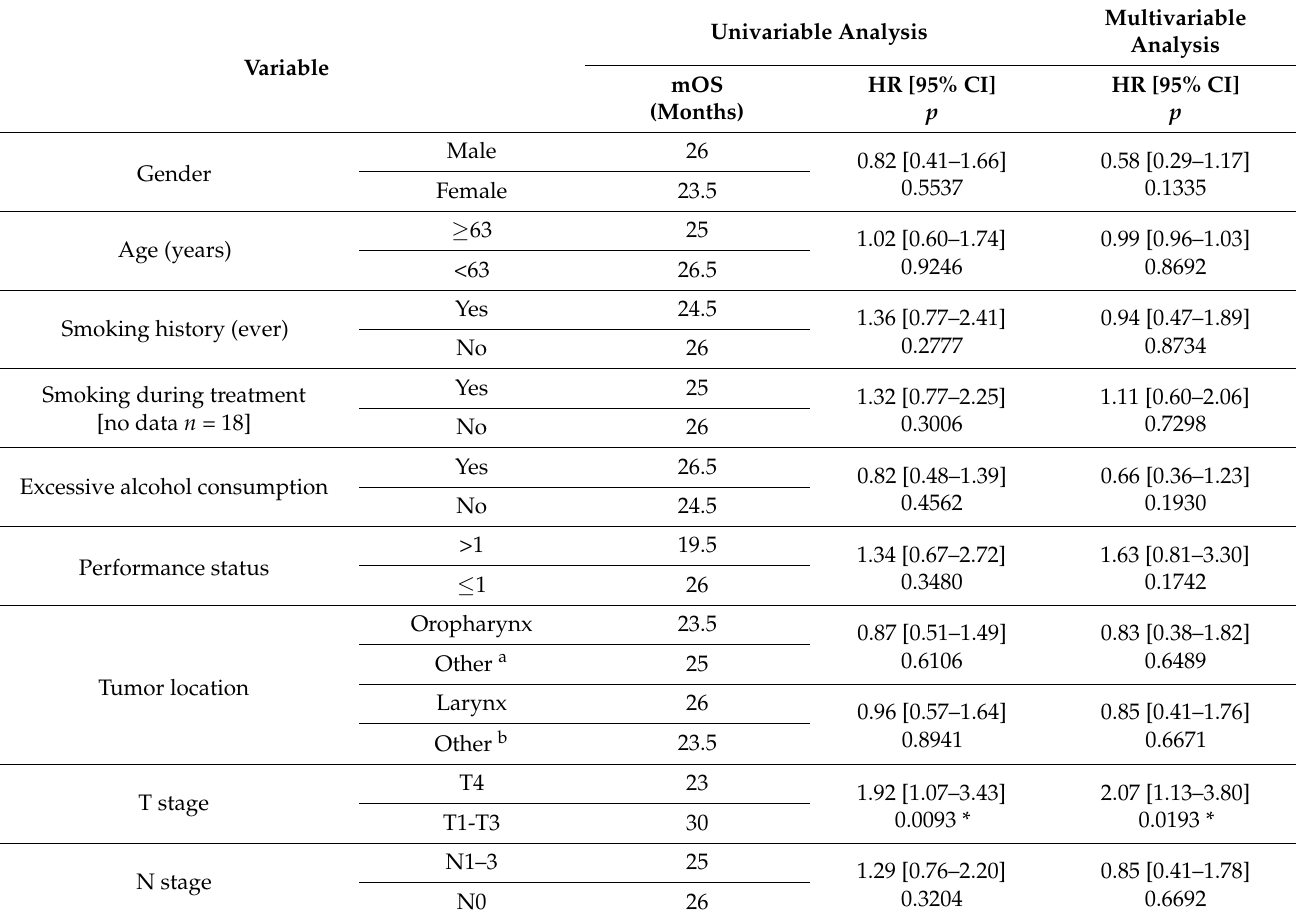
Table 6. The influence of demographic, clinical, nutritional, and genetic variables on